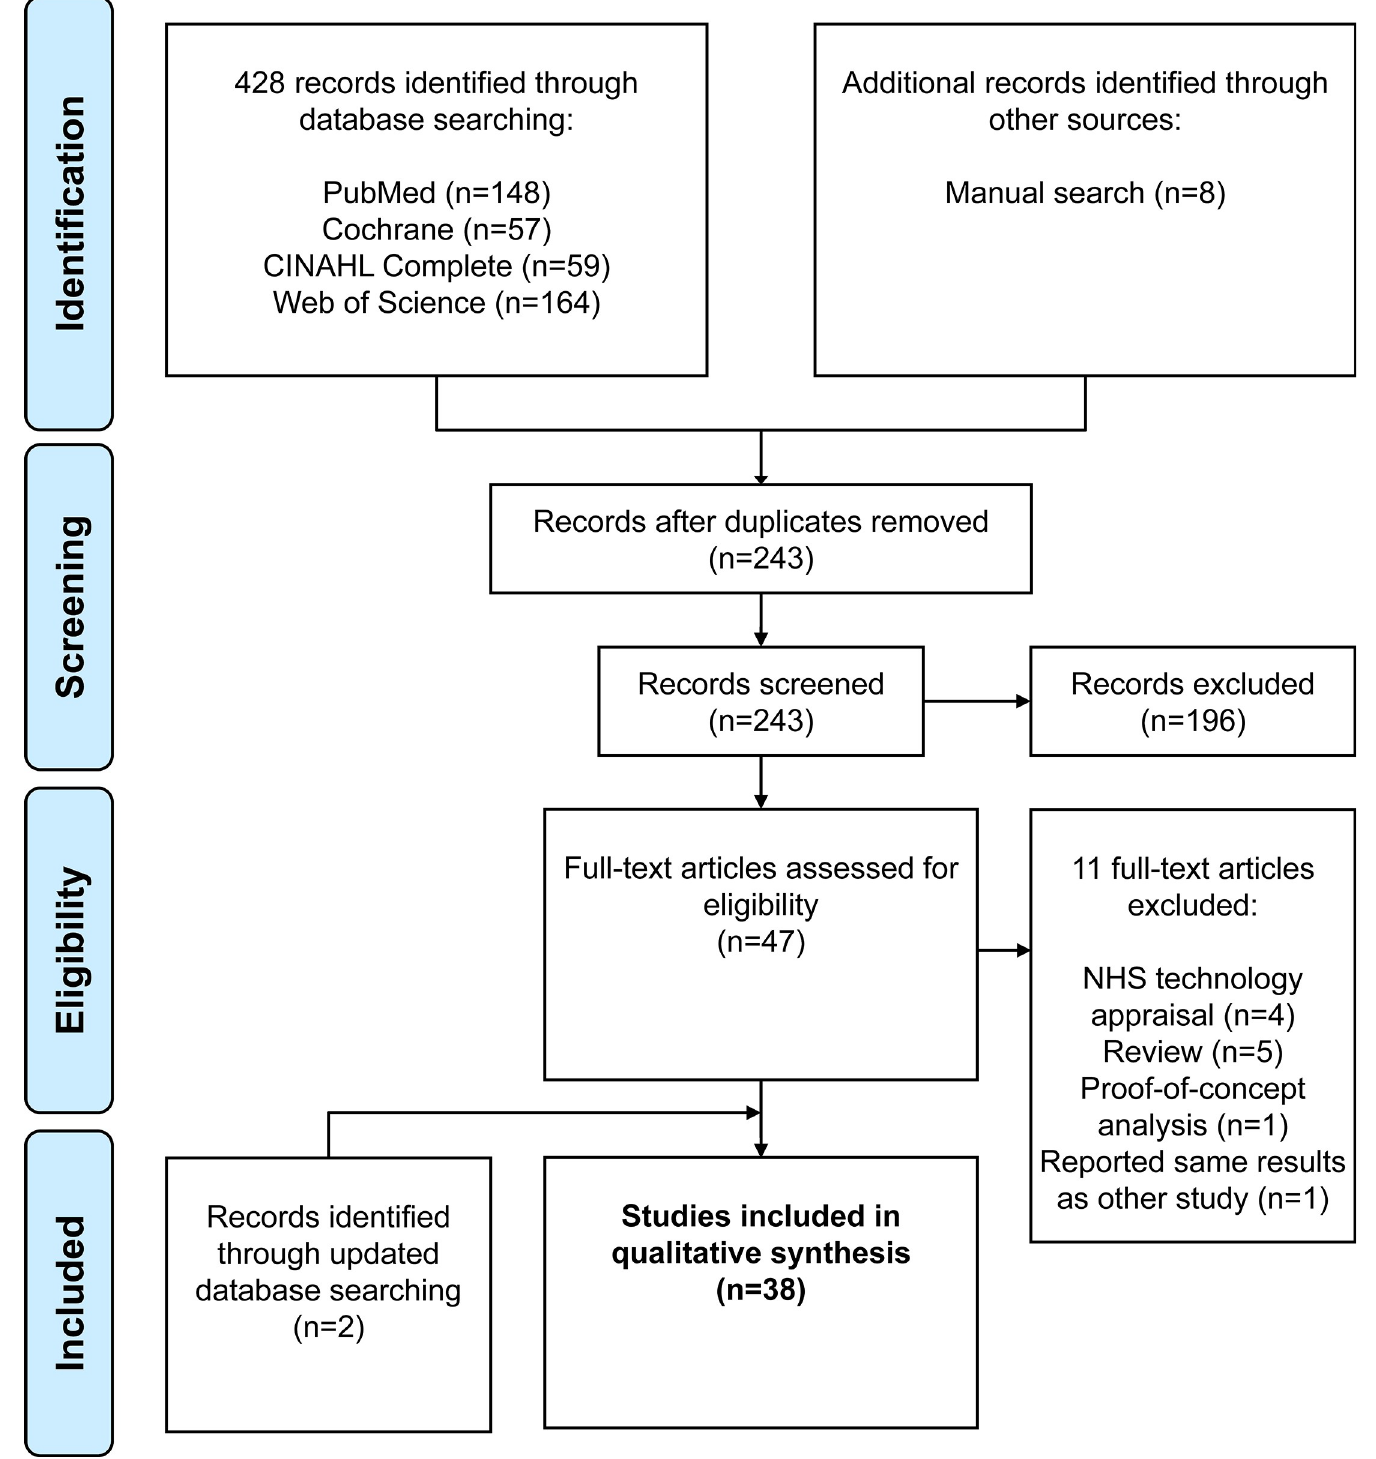
Fig 1. Flow chart of the selection process based on the PRISMA statement [92].